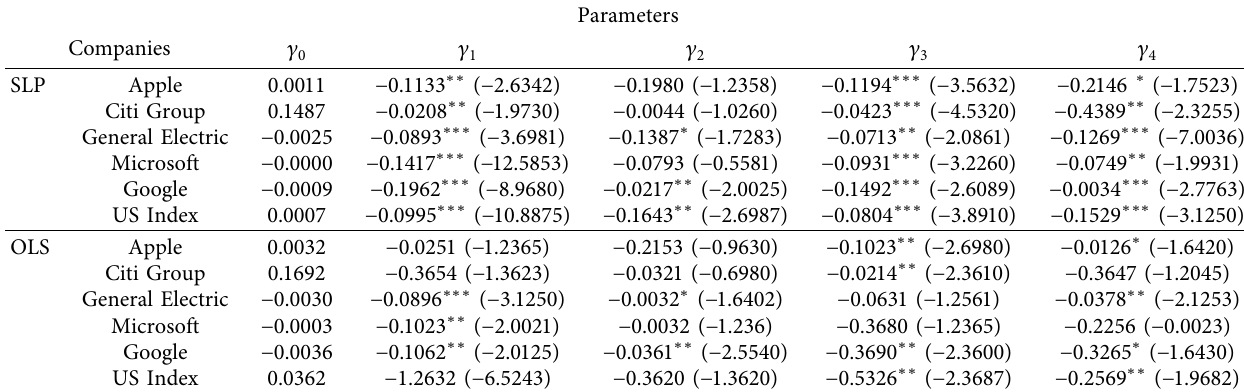
Table 6: Coefficient outputs for the US without